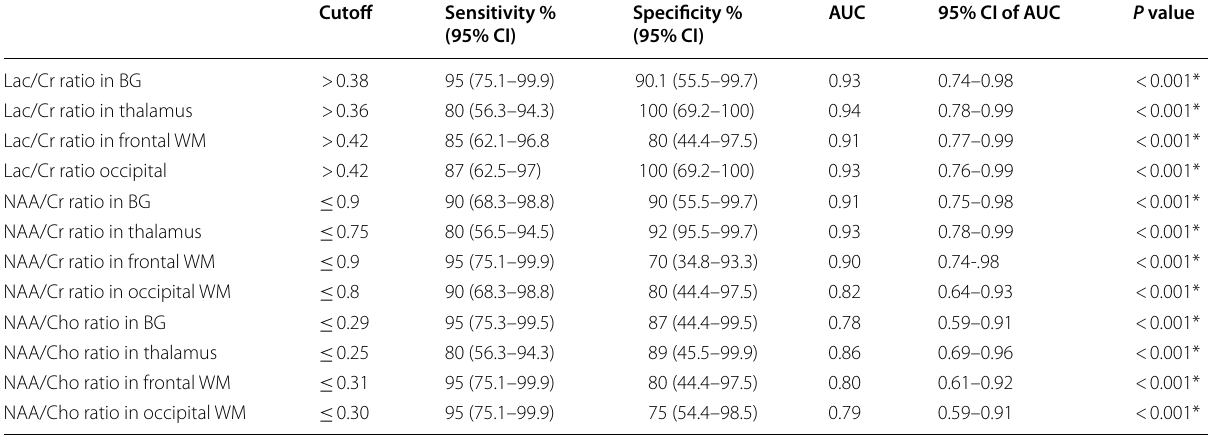
*Significant at p <